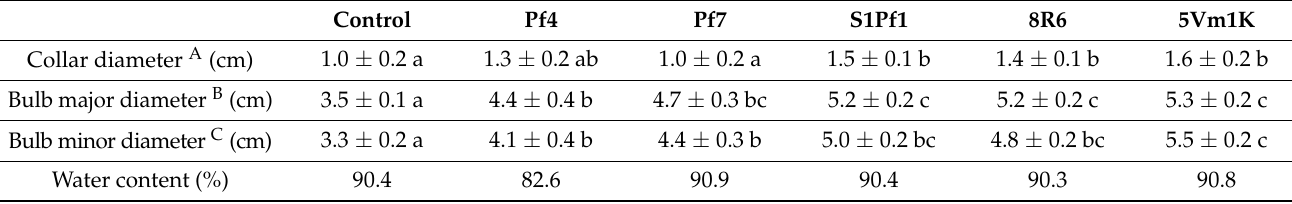
Figure 3. The number of fruits produced by zucchini plants inoculated or not with the five PGPBs during two months of growth. The * indicates a sampling time where significant differences among the treatments were observed; in the table, the different letters indicate significant differences among the treatments according to the Kruskal–Wallis test followed by the Dunn test ( p < 0.05). No significant differences were recorded for the number of aborted fruits (Figure 4). However, the number of female flowers monitored every two days revealed that at the second and third sampling time the number of flowers increased in plants inoculated with